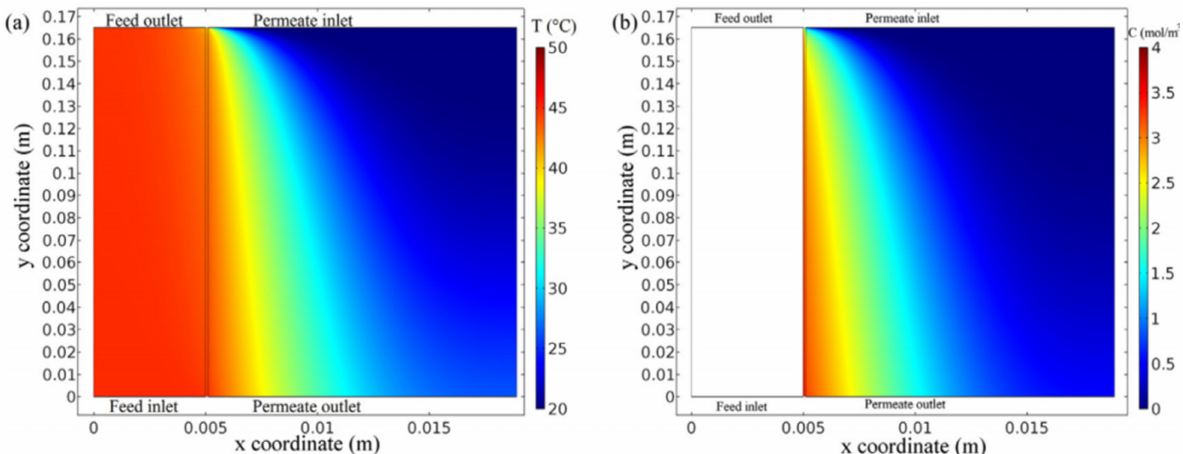
Figure 9. Results of the simulation of the flat sheet SGMD module [23]. Reproduced with permission from Elsevier, 2018. ( a ) The temperature distribution in all domains and ( b ) distribution of the water vapor concentration in the membrane media and permeate channel (v Feed = 5.6 × 10 − 3 m/s, v Permeate = 9.3 × 10 − 2 m/s, T Feed = 45 ◦ C, T Permeate = 20 ◦